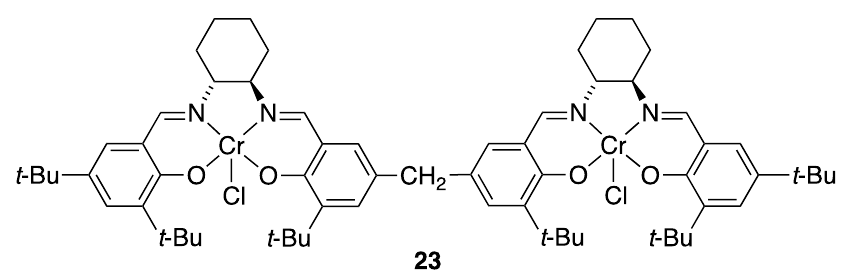
Figure 7. Dimeric Cr–salen complex 23 .